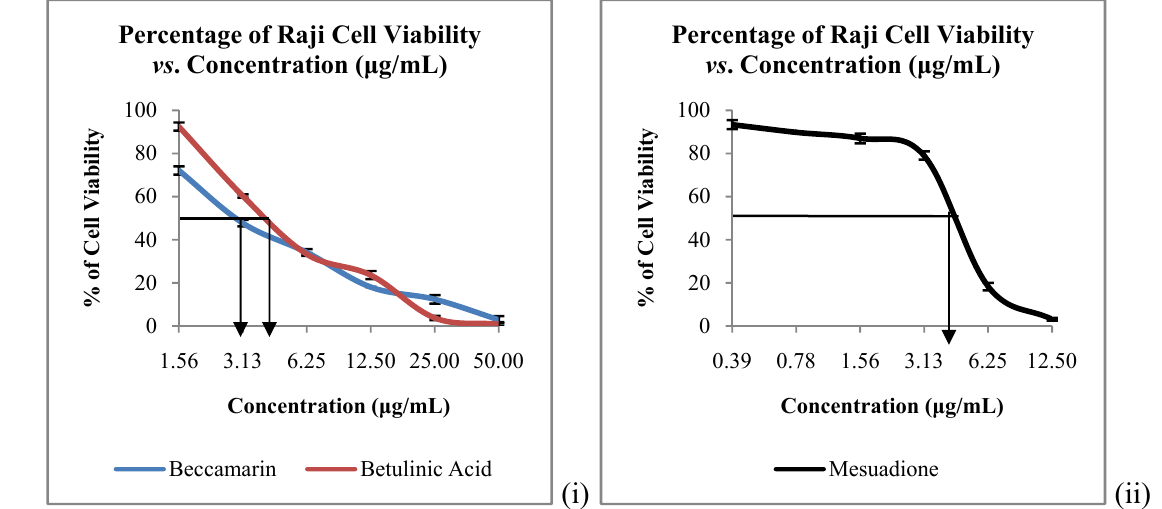
Figure 3. Cytotoxicity of Compounds 1 – 6 towards (i), (ii), (iii) Raji; (iv) SNU-1; (v) K562 and (vi) LS174T Cells. Bars denote statically significant differences at p < 0.05. Each data point represents the mean ± SD of three independent